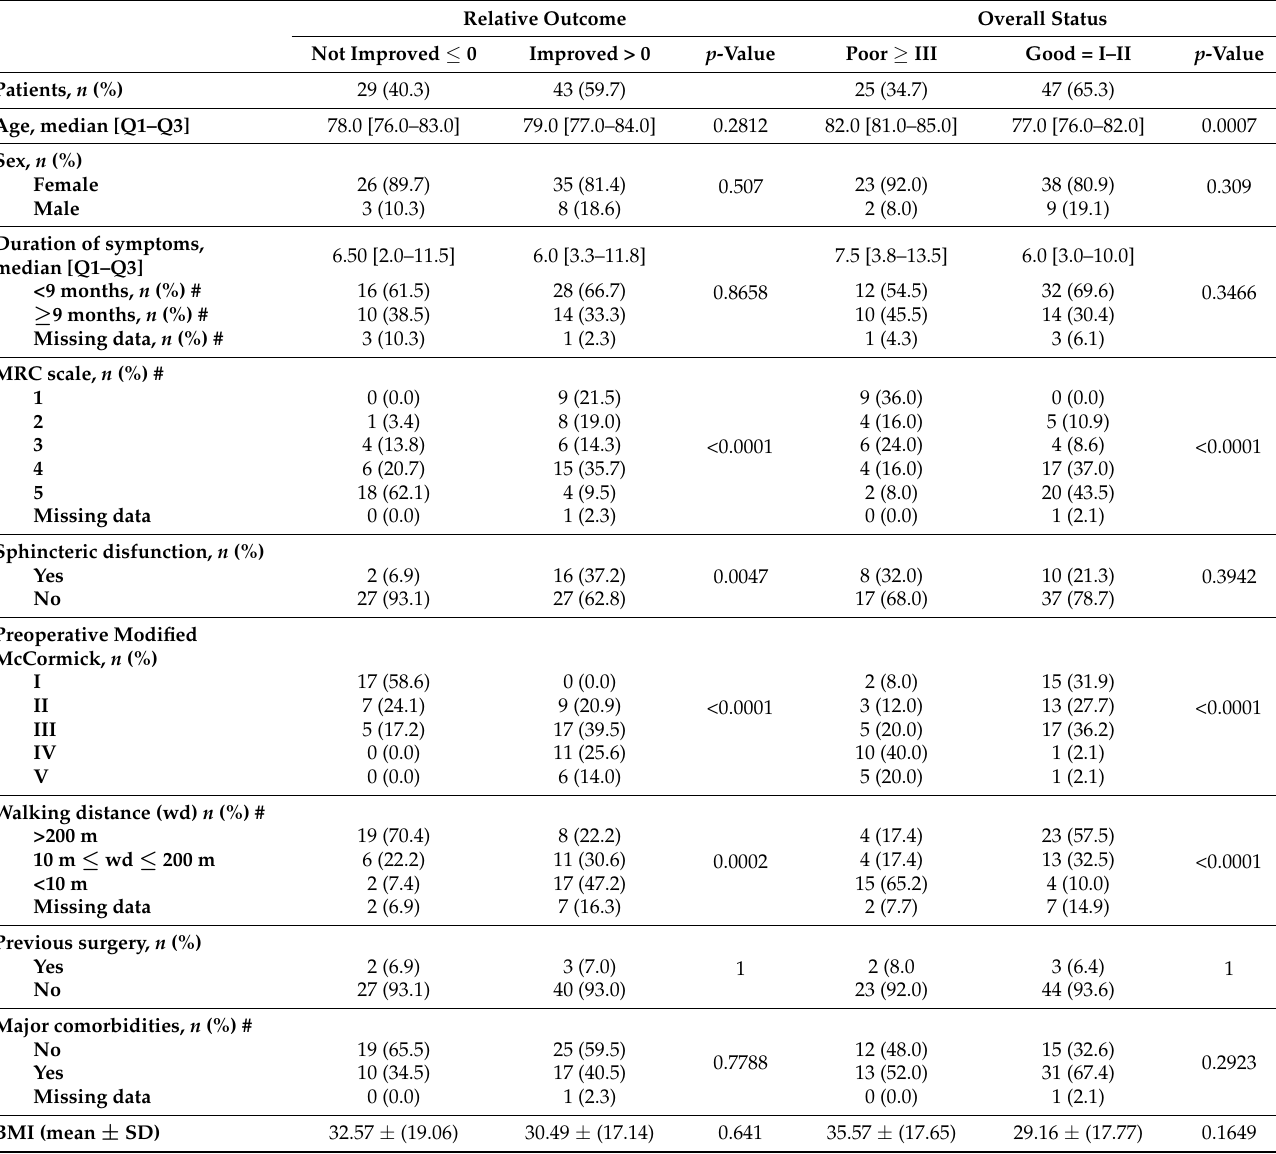
who showed a positive ∆ mod McCormick ( n = 43; improved group) and patients who had a ∆ modified McCormick ≤ 0 ( n = 29). Univariate analyses are entirely reported in Table 3. Sex, age, presence of comorbidities, ASA score ≥ 3, BMI, and previous surgery for spinal meningioma did not have any significant impact on postoperative functional improvement. Impaired preoperative motor function and high value (disability) of mod McCormick showed correlations with a postoperative functional improvement ( p < 0.0001 both). Preoperative sphincter dysfunction was more likely seen in the improved group (37.2% vs. 6.9%, p = 0.0047). A shorter walking distance ( ≤ 200 m) before surgery was often observed in the group with good relative outcomes (77.8% vs. 29.6%, p = 0.0002). Neither tumor volume nor tumor location showed a significant difference between the groups. Multiple-level involvement was more represented in the improved group (53.5% vs. 28.6%, p = 0.0384). Postoperative neurological complications occurred less frequently in the improved group (4.7% vs. 24.1%, p = 0.0255). Overall, these data suggest that patients with worse preoperative neurological status are more likely to improve it after surgery for SM. Table 3. Univariate predictors of postoperative outcome improvement (represented by positive ∆ modified McCormick) and overall status (estimated with follow-up modified McCormick) ( n = 72). Relative Outcome Overall Status Not Improved ≤ 0 Improved > 0 p -Value Poor ≥ III Good = I–II p